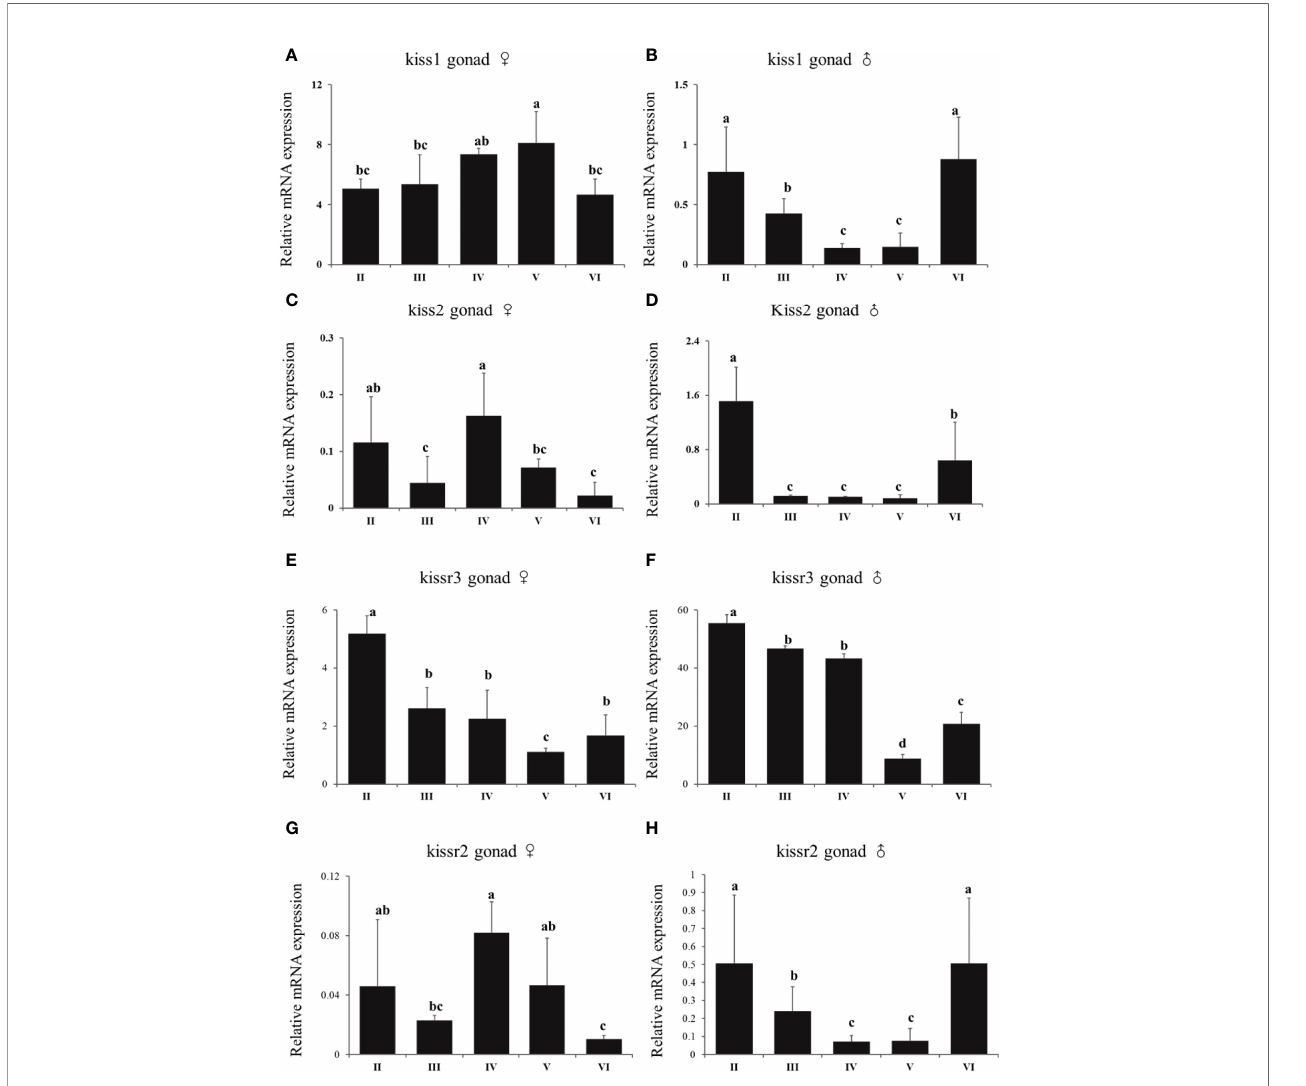
FIGURE 9 | Expression pro fi les of kiss/kissr genes throughout the reproductive cycle in the gonads of female (A, C, E, G) and male (B, D, F, H) . Error bars are presented as the mean±SEM. Different letters above bars represent statistical signi fi cance (p < 0.05) between two reproductive